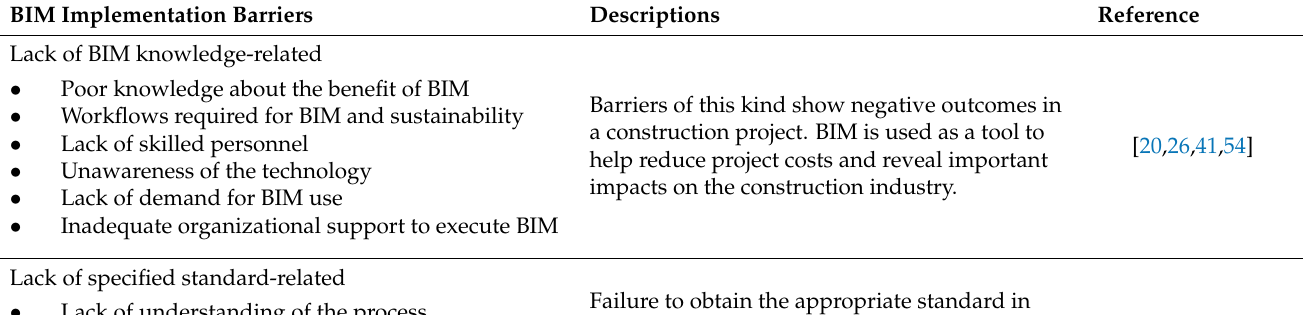
Table 4. BIM implementation barriers in construction management